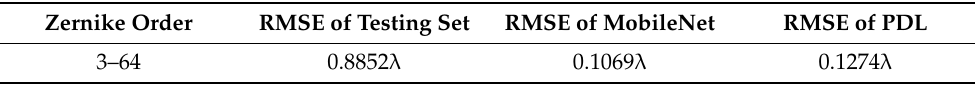
Figure 6. Comparison of the PSF image with 3–64 orders of Zernike polynomials (intensity reversed): ( a ) original distribution, ( b ) self-supervised learning recovery spots, and ( c ) the correction spot. (The pixel size is 5.5 µ m and the image size is 256 × 256). Table 3. Comparison of accuracies (RMSE) of equivalent wave-fronts from the Zernike coefficients estimated in the experiments between PDL and MobileNet (3–64